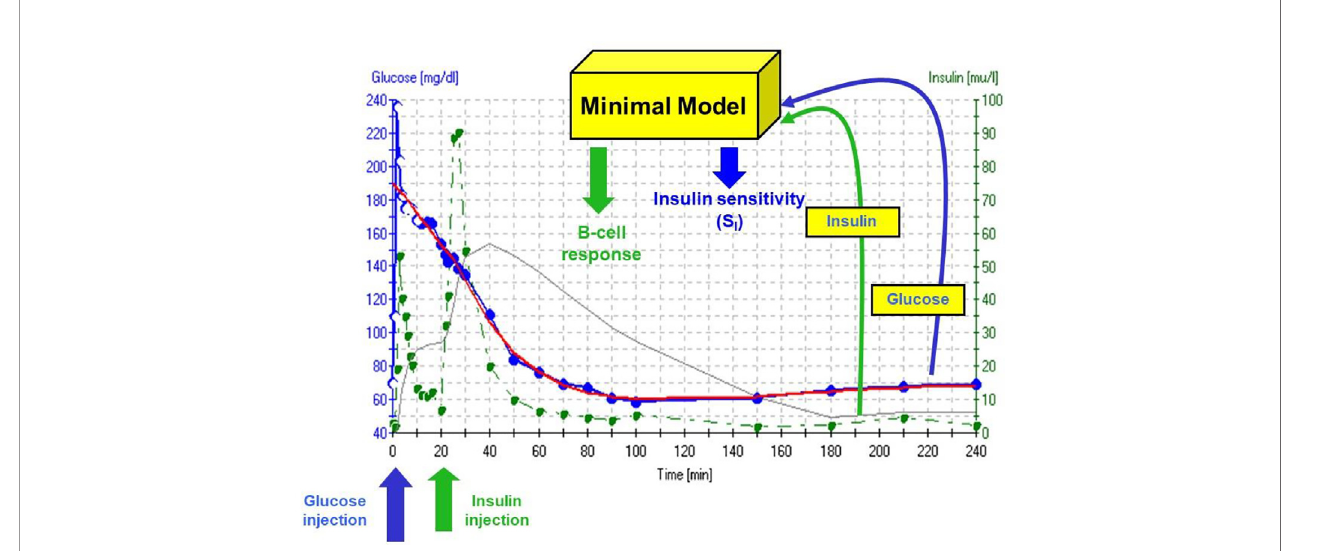
FIGURE 10 | IVGTT protocol and minimal model output. Insulin data are ” input ” to the minimal model, which determines the best fi t of the glucose dynamics and model parameters for that